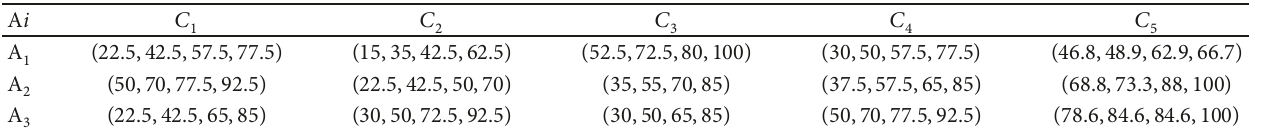
Table 8: Fuzzy evaluation matrix.